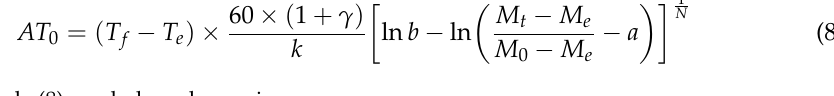
Table 7. Formula (8) symbols and